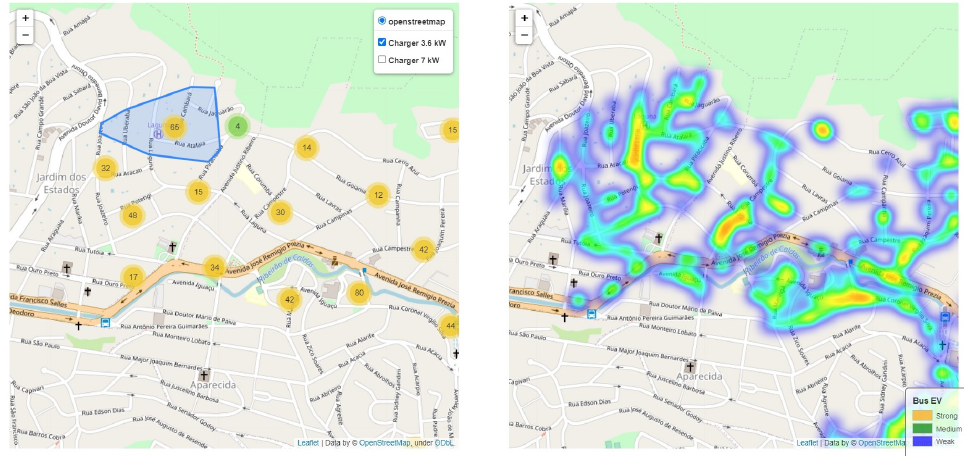
Figure 9. HC map—Feeder 16.